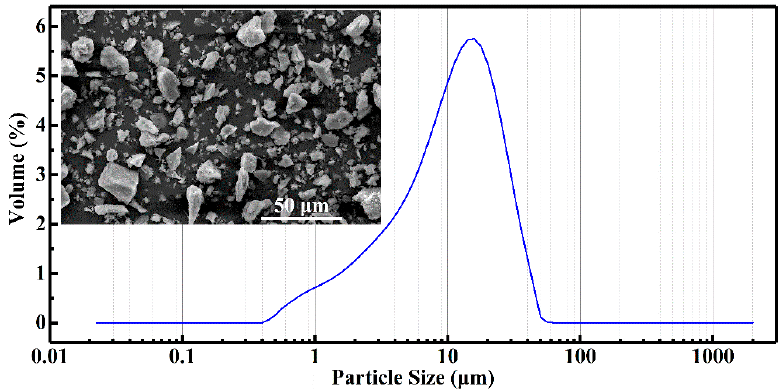
Table 2. XRF analysis of the FD powder.